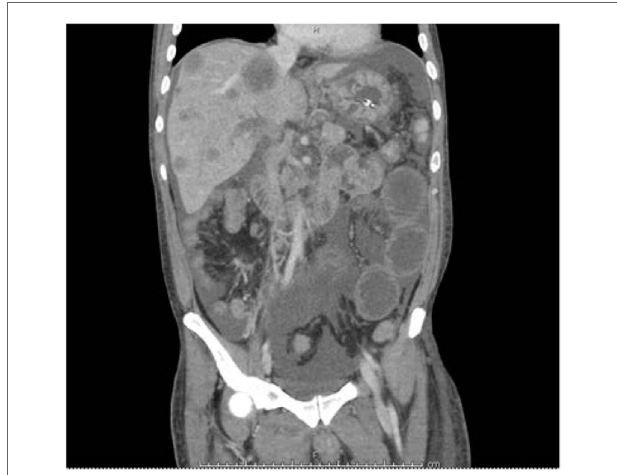
FiGURe 1 | Frontal view panel showing liver metastasis and thickening of deuodenum and jejunum.